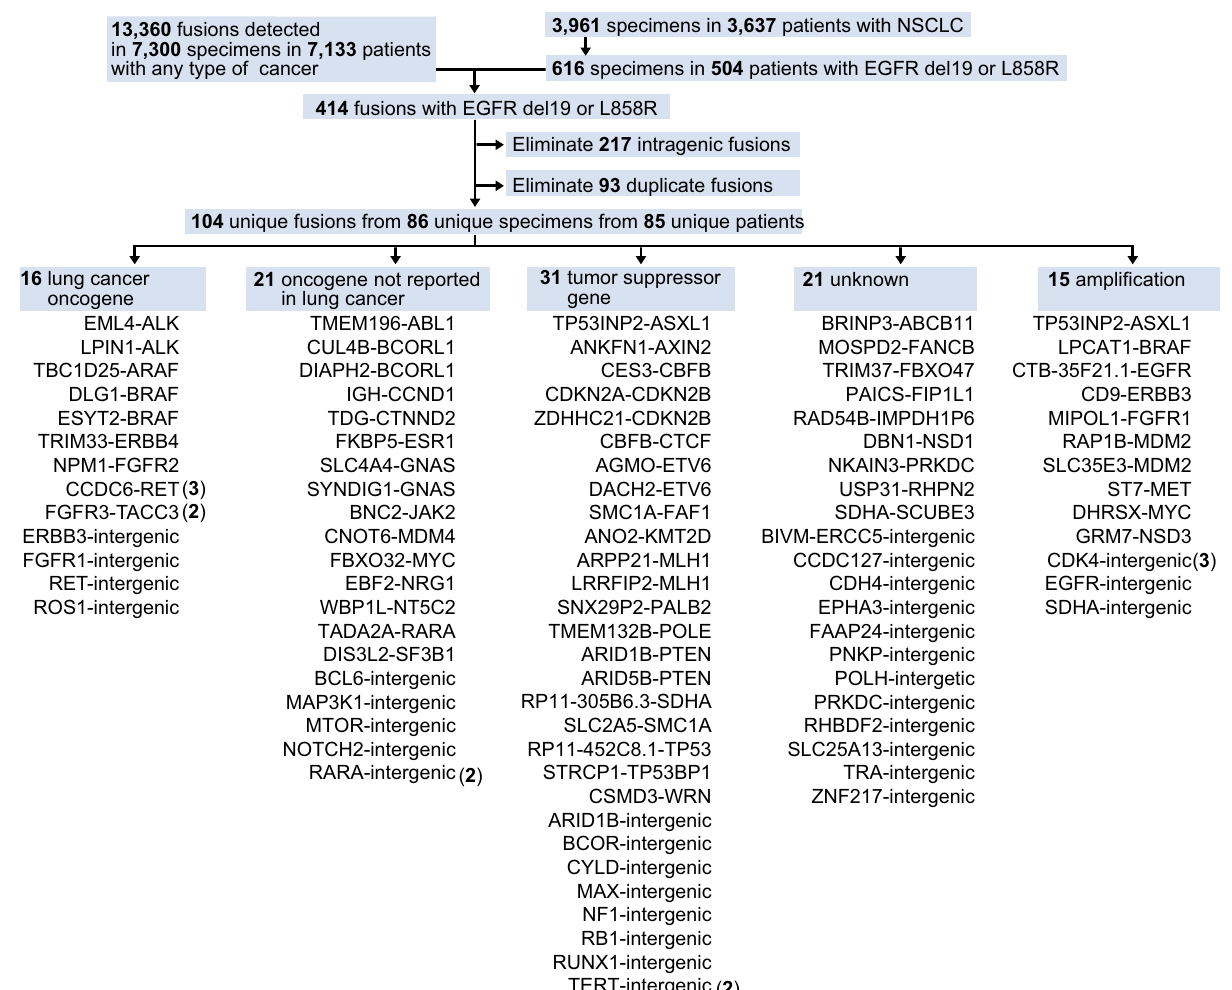
Fig. 2 | Comprehensive analyses of all fusions in EGFR mutant lung cancer. Prospectively collected genetic data on fusions from all cancer patients, and mutationaldatafrompatientswithnon-smallcelllungcancer(NSCLC;detectedby